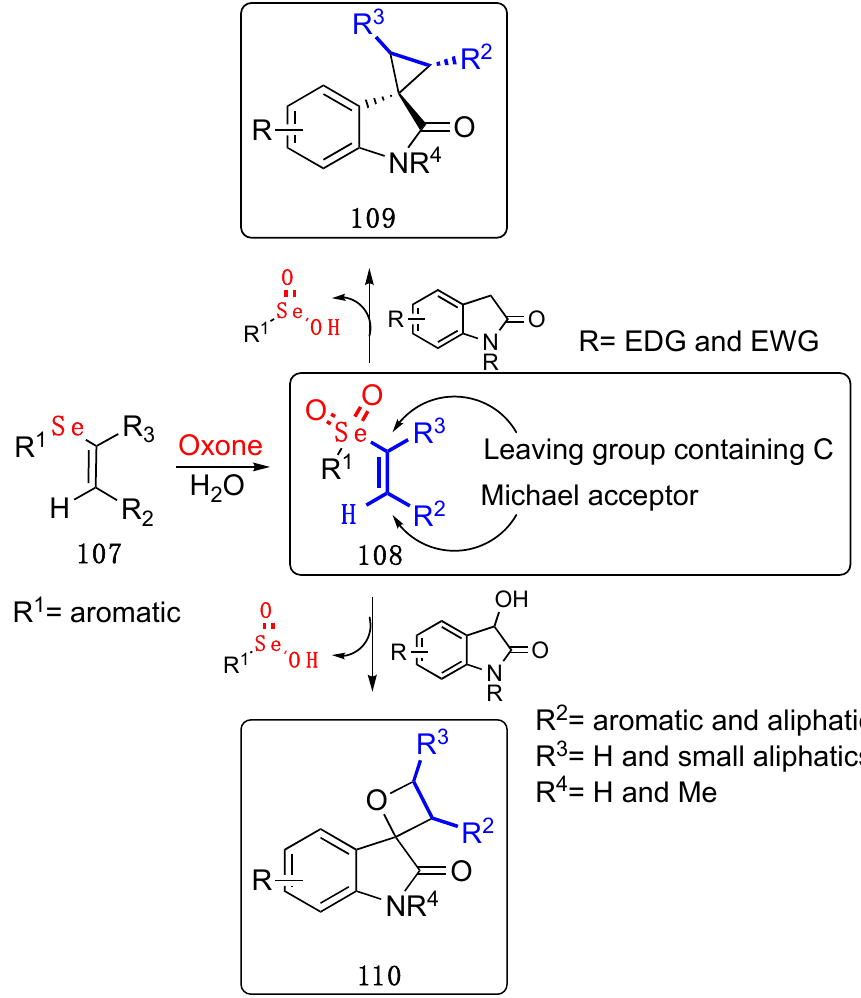
Scheme 52. Preparation of vinyl selenones and their use as double electrophilic species.